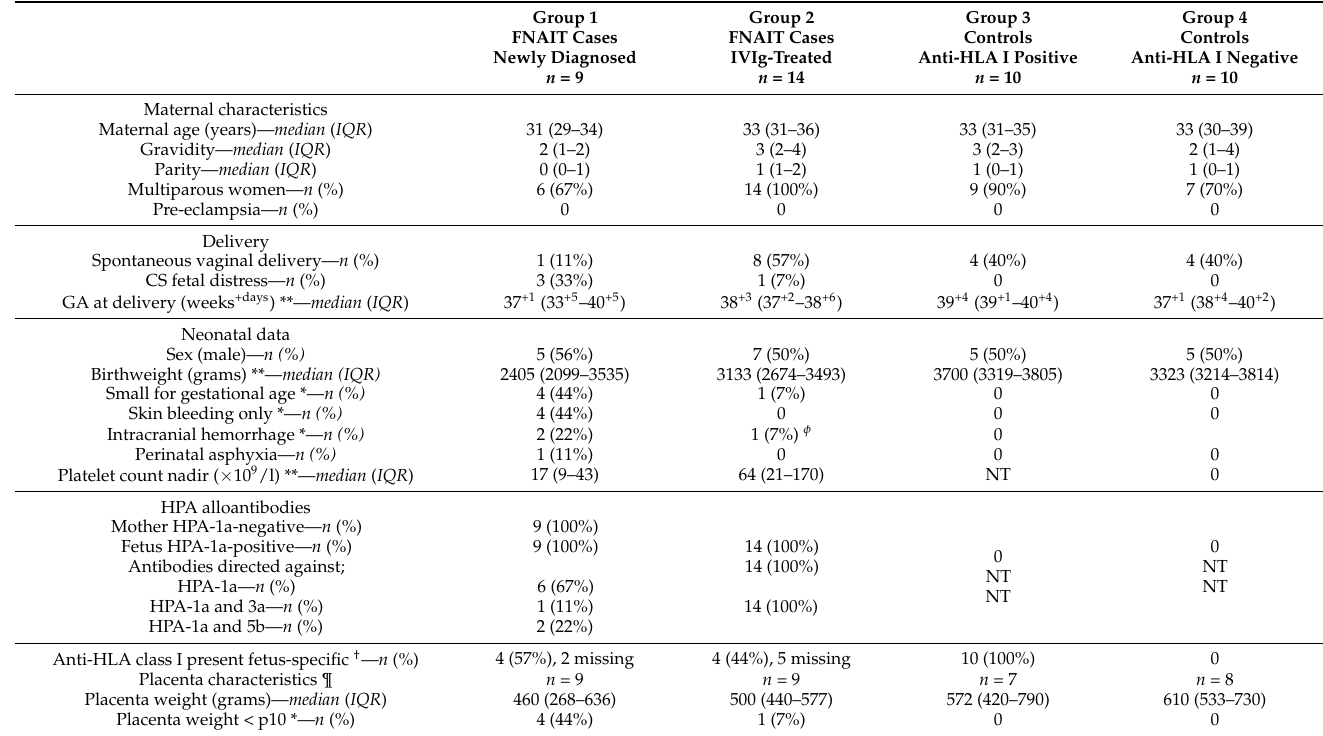
Table 1. Clinical